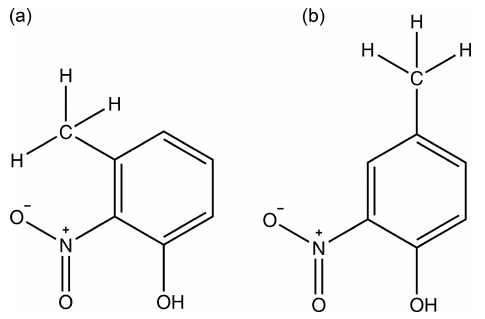
Figure 6. Diagram emphasising how the proximity of the bulky methyl group sterically hinders intermolecular interactions with the nitro group in 3-methyl-2-nitrophenol (a) but not in 4-methyl-2- nitrophenol (b)